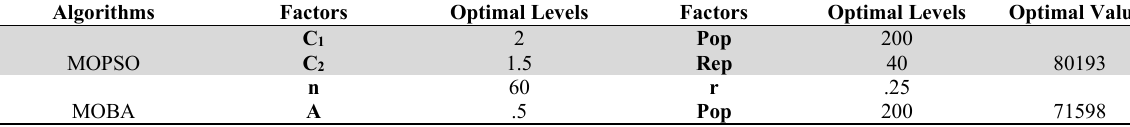
Optimal level of different parameters (WIP inventory model) Algorithms